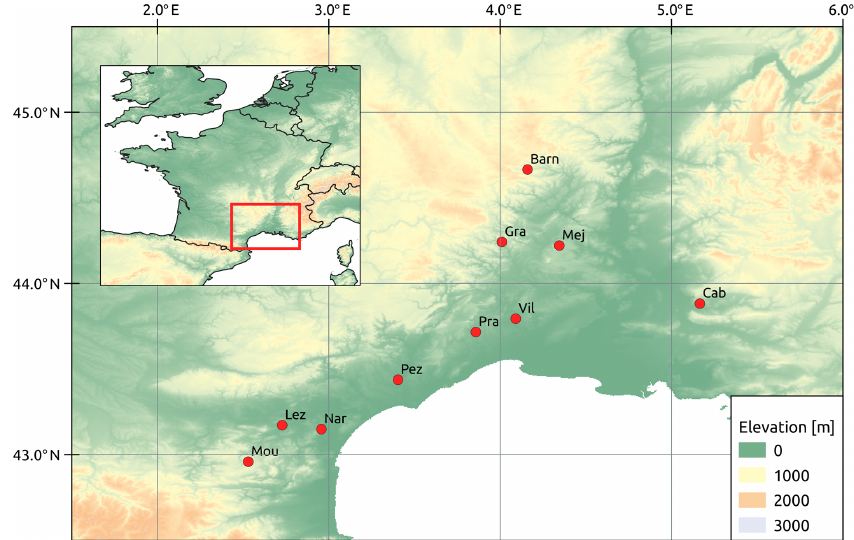
Figure 1. Localization of the study sites in southern